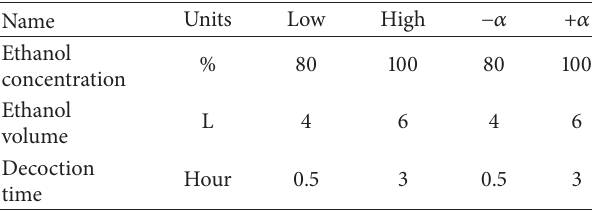
Table 1: Factors and levels of central composite design ( 𝛼 = 1